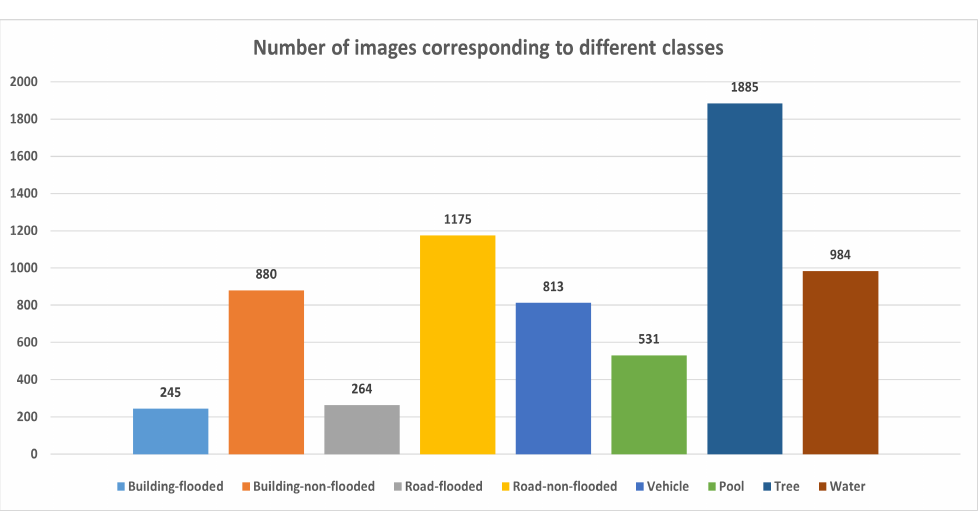
Figure 5. Distribution of images corresponding to different classes. Table 1. Number of instances per each